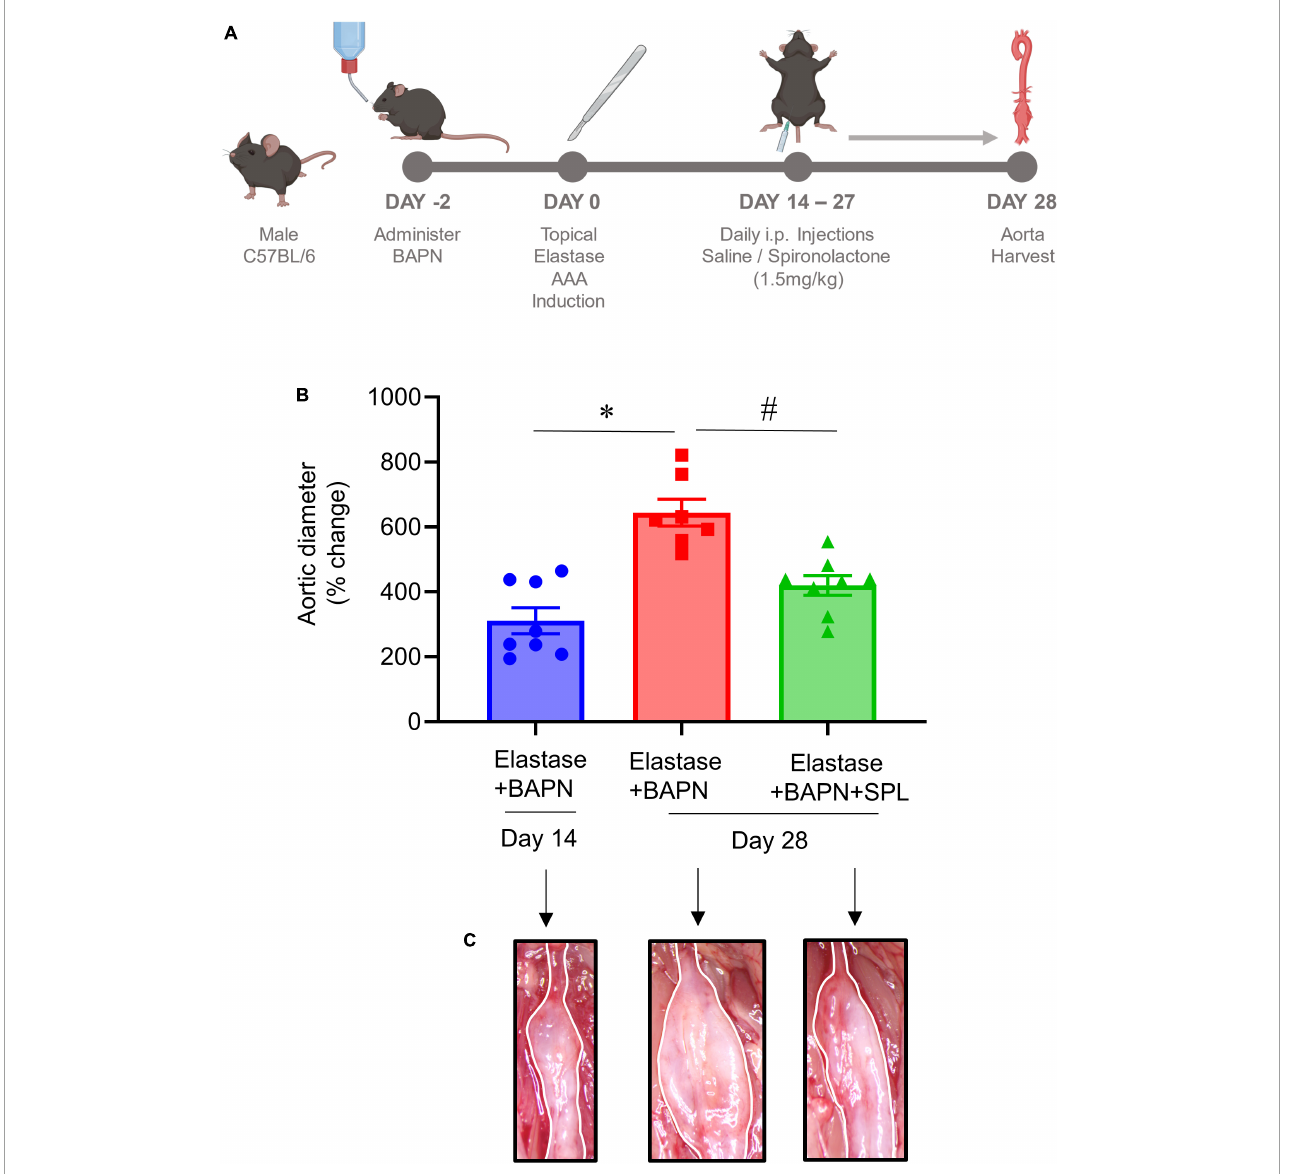
FIGURE4 Spironolactone inhibits aortic aneurysms in a chronic AAA model. (A) Schematic depicting the chronic AAA and aortic rupture model with elastase + BAPN treatment in WT mice. SPL treatment was administered in mice with pre-formed AAAs from day 14 onwards till harvest. (B) SPL treatment decreases aortic diameter of pre-formed aneurysms in elastase + BAPN-treated WT mice compared to elastase + BAPN-treated mice alone on day 28. ∗ P < 0.0001; # P = 0.001; n = 7–8/group. (C) Comparative representation of aortic phenotype in respective